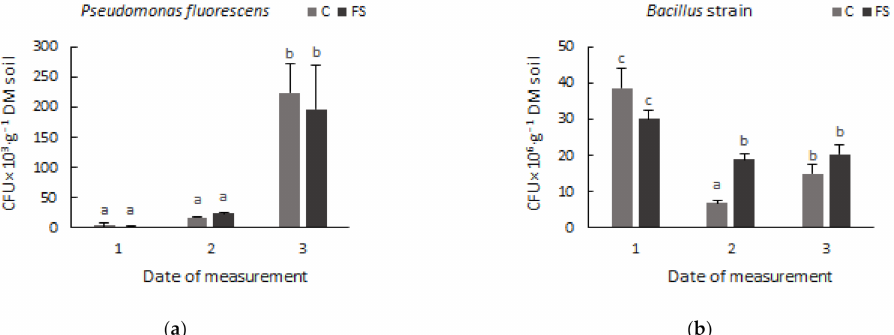
Figure 5. The number of ( a ) Pseudomonas fluorescens and ( b ) Bacillus in soil after fertilisation. Different letters above the error bars (i.e., ± SD) indicate significant differences ( p < 0.05) between means (Tukey post-hoc test).